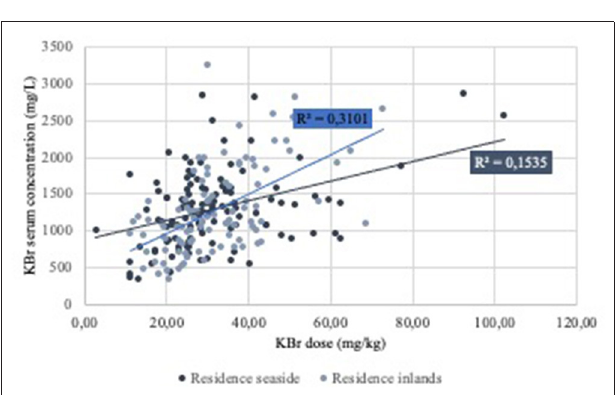
FIGURE 3 | Regression analysis of the potassium bromide (KBr) dose and serum concentration of the dogs grouped by residence.